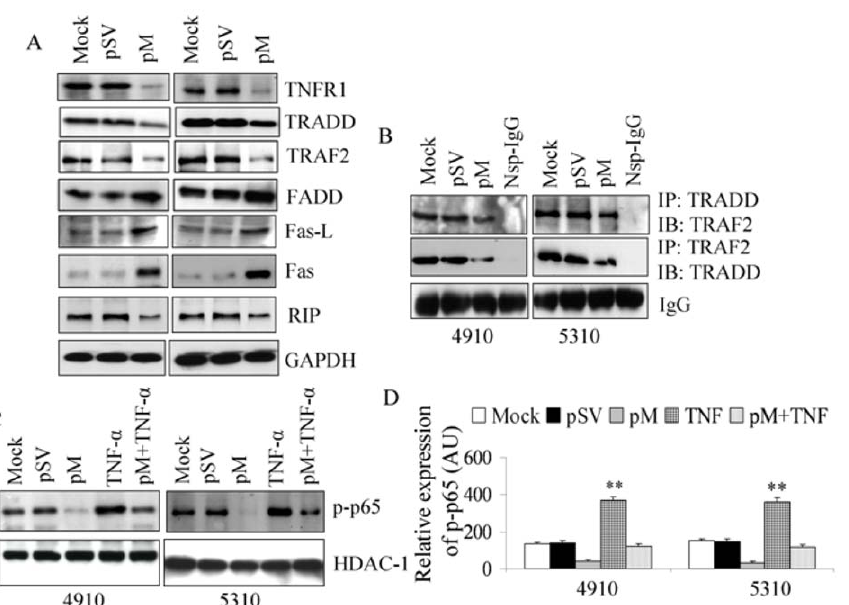
Figure 4. Inhibition of TNF- a mediated p65 phosphorylation by reduced interaction of TRADD-TRAF2. A. Whole cell lysates from mock, pSV- and pM-treated cells were subjected to Western blotting. Blots are representative of at least three independent experiments and blots were stripped and re-probed with GAPDH to check equal loading of samples. B. The immunoprecipitation experiments were performed by precipitating TRADD with anti-TRADD antibody or TRAF2 by using anti-TRAF2 antibody using m MACS TM protein G microbeads and MACS Separation Columns following manufacturer’s instructions (Miltenyi Biotec, Germany). Immunoprecipitates were electrophoresed and probed with anti-TRADD or anti- TRAF2 antibodies to confirm the interaction. The non-specific IgG (Nsp-IgG) precipitates were loaded as negative control. C. The 4910 and 5310 cells were treated with mock, pSV, pM, and the combination treatments were performed by 10 ng/ml TNF- a treatment at the end of 60 h transfection to either mock or pM. Cells were further incubated for another 12 h and collected at the end of the experiment. Whole cell lysates were subjected Western blot analysis. The experiment was repeated thrice to verify results. D. The expression levels of phospho-p65 were quantified using ImageJ 1.42 (NIH) and plotted in the bar diagram with mean 6 SE values obtained from at least three individual repetitions. The significant difference among different treatments were indicated by ‘‘**’’, at p , 0.01.